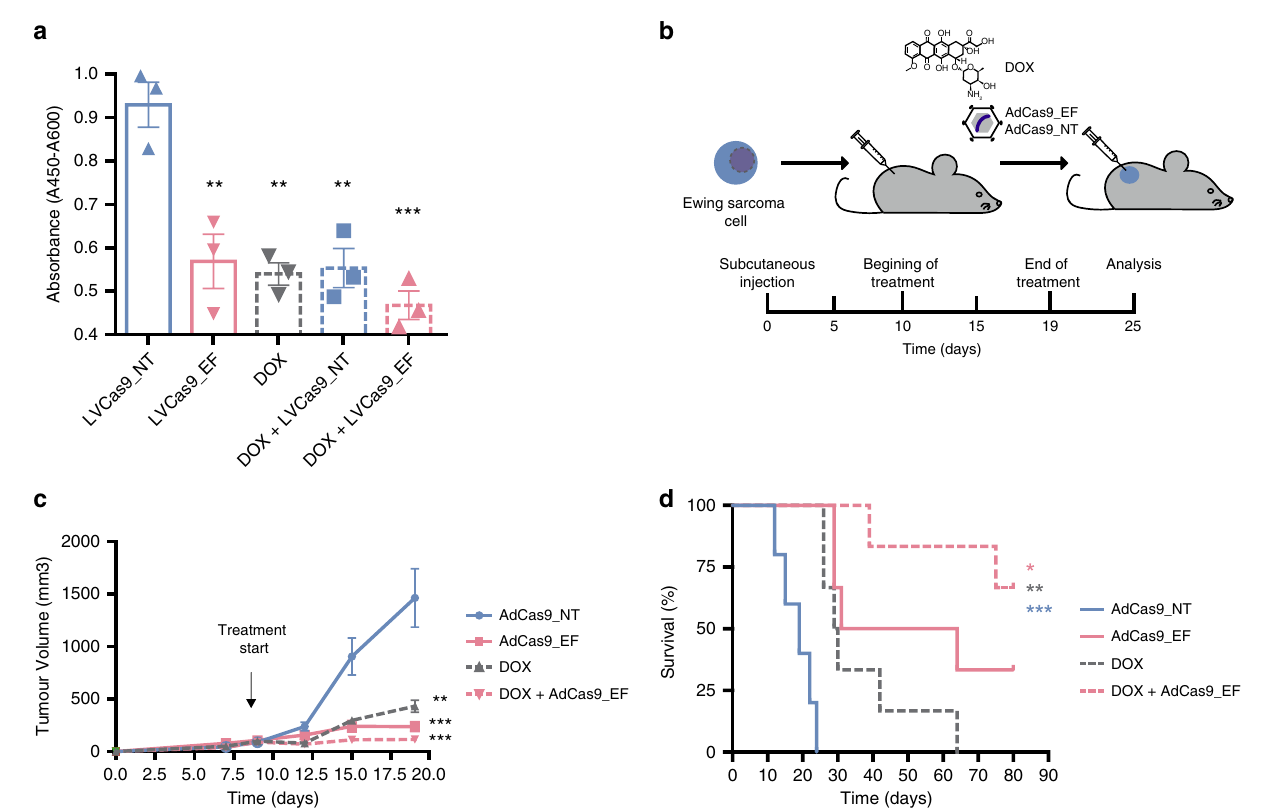
Fig. 5 Combined approach of EWSR1-FLI1 deletion with doxorubicin inhibits tumor growth in xenograft models. a WST-1 cell proliferation analysis of A673 cell treated with CRISPR-deletion or doxorubicin as monotherapy, or as combined therapy and controls ( n = 3 independent experiments) (LVCas9_NT vs LVCas9_EF ** p = 0.01, LVCas9_NT vs Dox ** p = 0.002, LVCas9_NT vs Dox + LVCas9_NT ** p = 0.005, LVCas9_NT vs Dox + LVCas9_EF *** p = 0.0001). b Diagram showing the approach for the in vivo xenograft treatment. A673 cells were subcutaneously injected into immunode fi cient mice and tumors were allowed to develop (~150 mm 3 in size). Tumors were then injected with AdCas9_EF edition vector, doxorubicin (DOX), AdCas9_NT control vector or their combination at days 9, 12, 15, and 18. Mice were sacri fi ced when tumor volume reached 1500 mm 3 . c Tumor growth over the 19 days following subcutaneous cells implantation. (AdCas9_NT n = 5; AdCas9_sgEF n = 6; DOX n = 6, DOX + AdCas9_EF n = 6 animals) (AdCas9_NT vs DOX ** p = 0.003, AdCas9_NT vs AdCas9_EF *** p = 9e-4, AdCas9_NT vs DOX + AdCas9_EF *** p = 5e-4). d Kaplan – Meier survival curve comparing mice treated with CRISPR-deletion or DOX as monotherapy, or as combined therapy and controls. (AdCas9_NT n = 5; AdCas9_sgEF n = 6; DOX n = 6, DOX + AdCas9_EF n = 6 animals) (DOX + AdCas9_EF vs AdCas9_EF * p = 0.035, DOX + AdCas9_EF vs DOX ** p = 0.003, DOX + AdCas9_EF vs AdCas9_NT *** p = 0.0007). Plot shows medians and ranges; error bars indicate the s.e.m. for the averages across the multiple experiments; p -values are represented (* p ≤ 0.05, ** p ≤ 0.01, *** p ≤ 0.001). A two-tailed unpaired t -test was used for statistical analysis of a , c , and Log- rank test for d